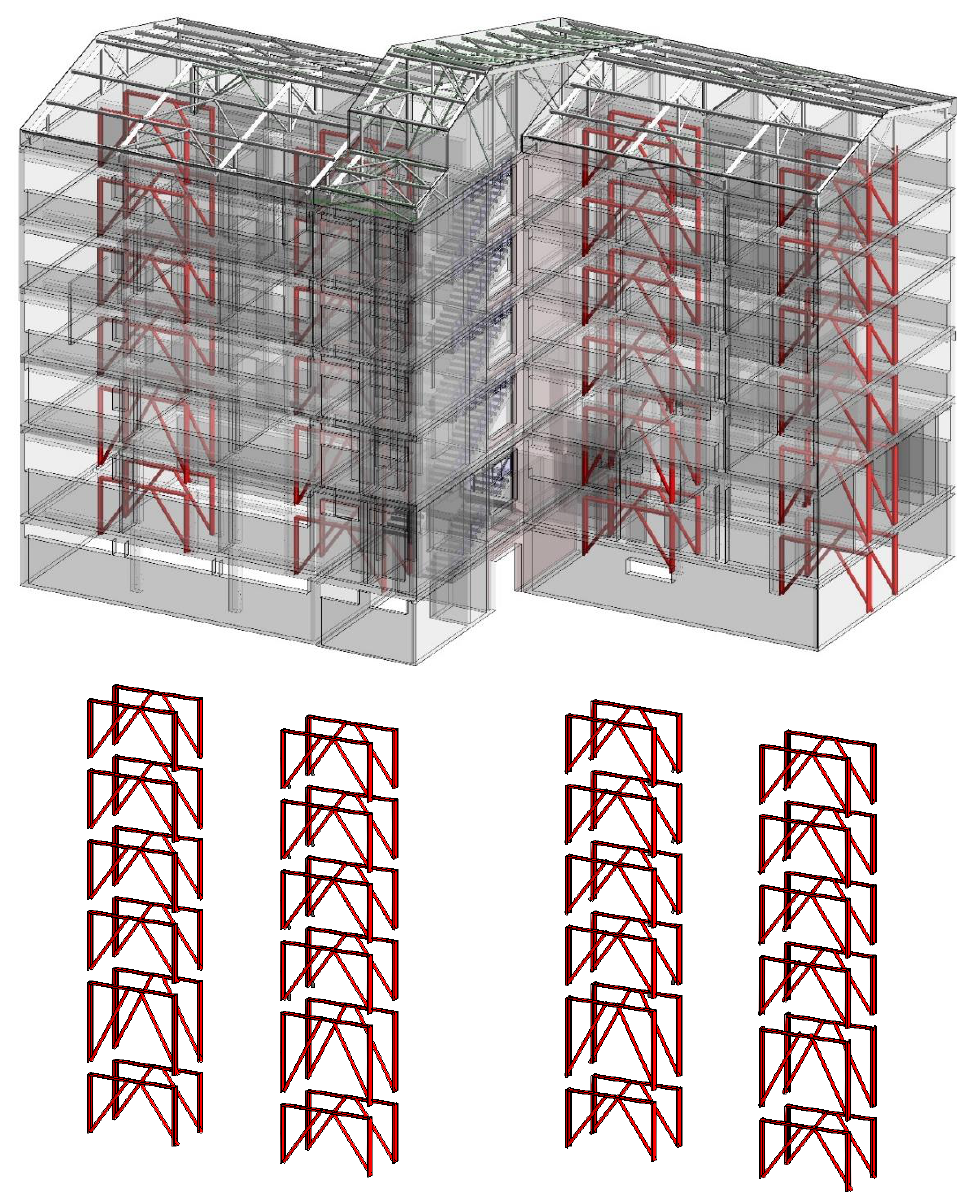
Figure 23. New steel frames (red) installed as an infill of existing RC frames.